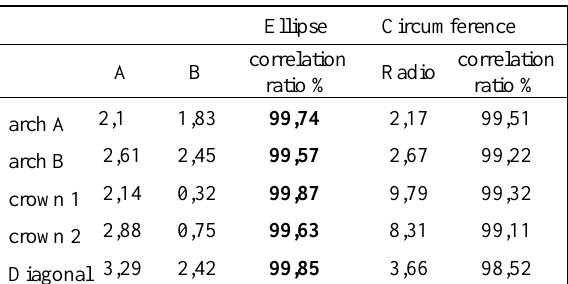
Figure 6. Vault contours: portions A and